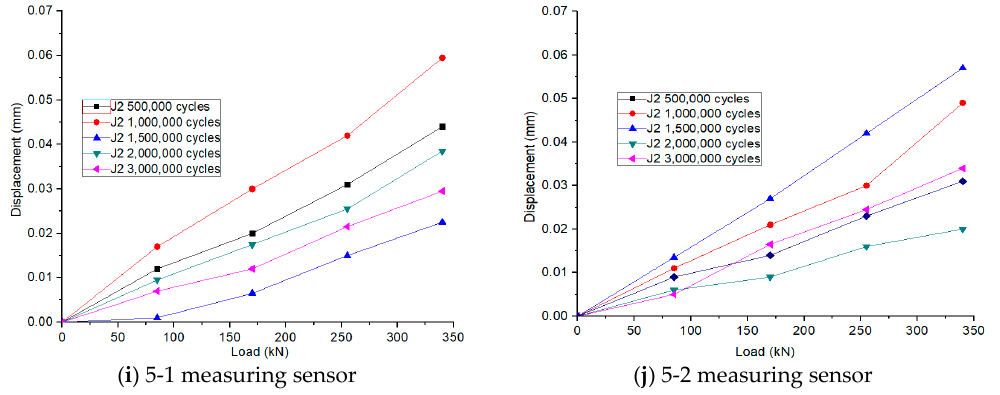
Figure 12. Load-displacement curves.